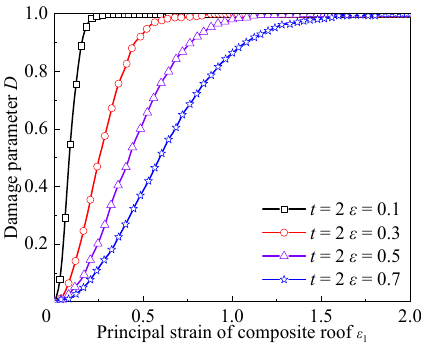
Figure 6. Relationship between damage parameters and principal strain of composite roof under different Weibull scale parameters.